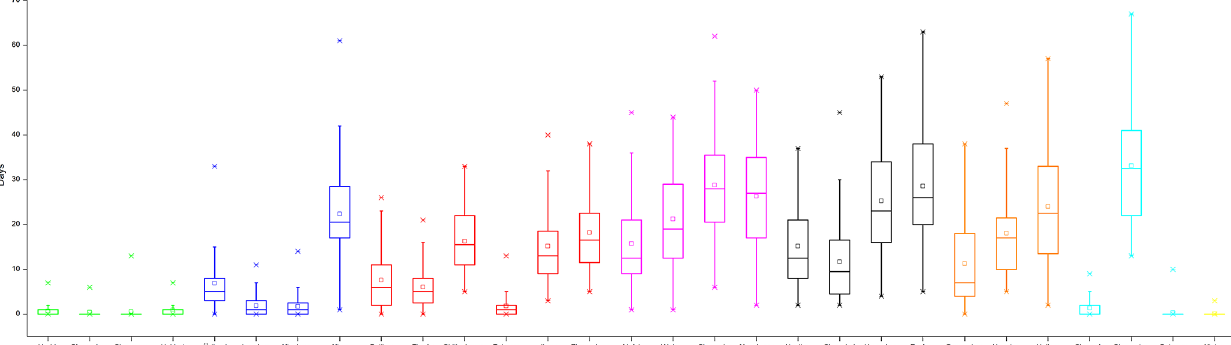
Figure 3. Distribution of D 35 in 29 cities from 1955 to 2014 (green color: NE; blue color: NW; red color: NC; purple color: CC; black color: EC; orange color: SC; cyan color: SW; yellow color: QT). Boxes indicate the interquartile spread (25th and 75th quantiles) with the horizontal line indicating the ensemble median and the whiskers showing the extreme range of D 35 in 29 cities. There has been no high- temperature weather in which daily T max exceeds 35 ◦ in Kunming and Lhasa cities in the past 60 years. Therefore there are 29 cities shown in this figure.